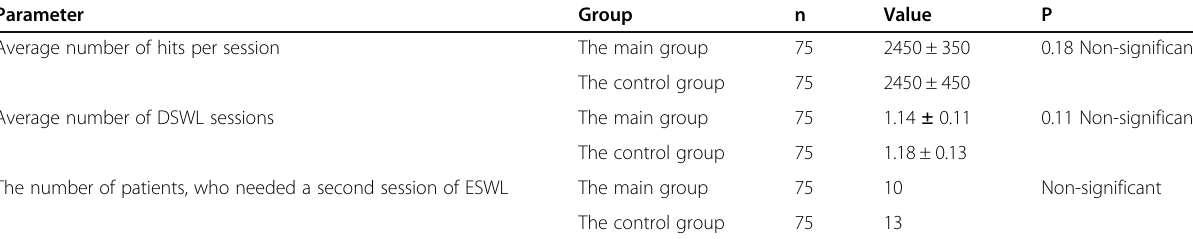
Table 5 Characteristics of shockwave lithotripsy sessions in groups